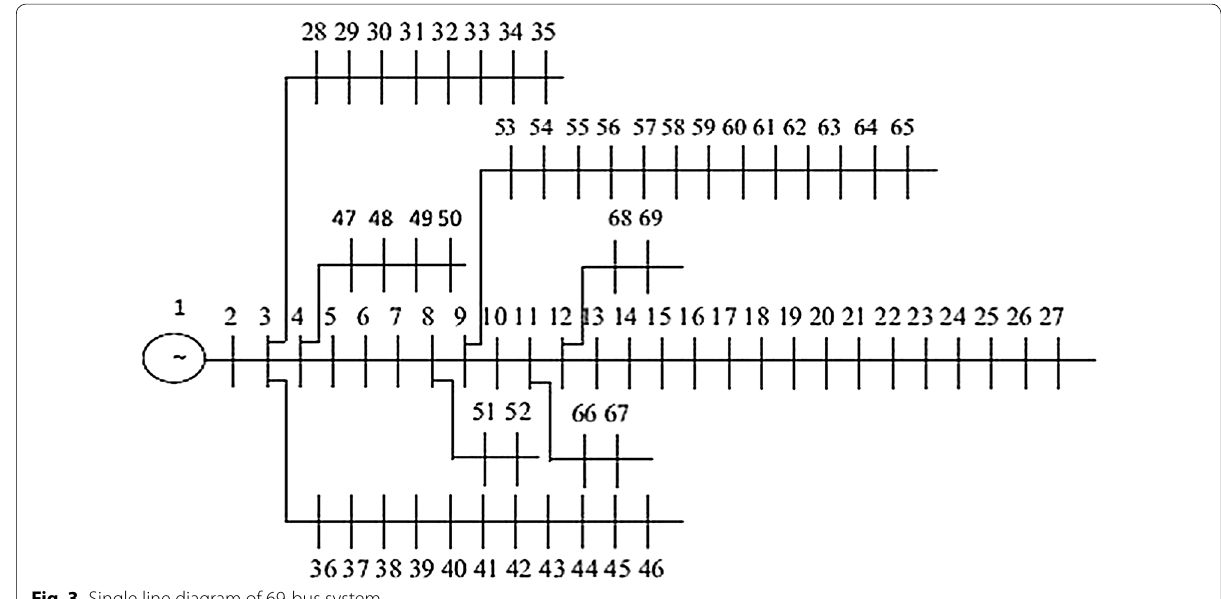
Fig. 3 Single line diagram of 69-bus system